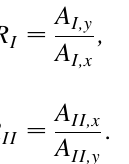
FIG. 1. (Color) Eigentune split in a 2D decoupling scan.